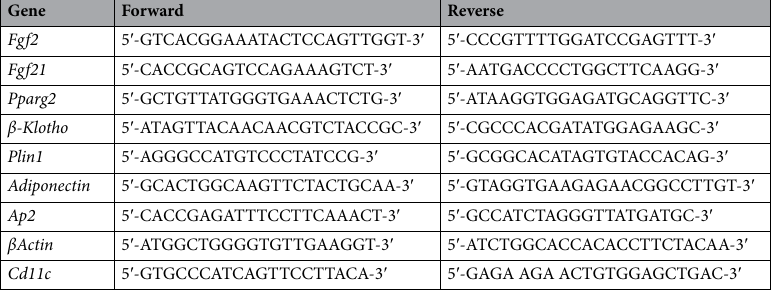
Table 1. Primers used in quantitative real